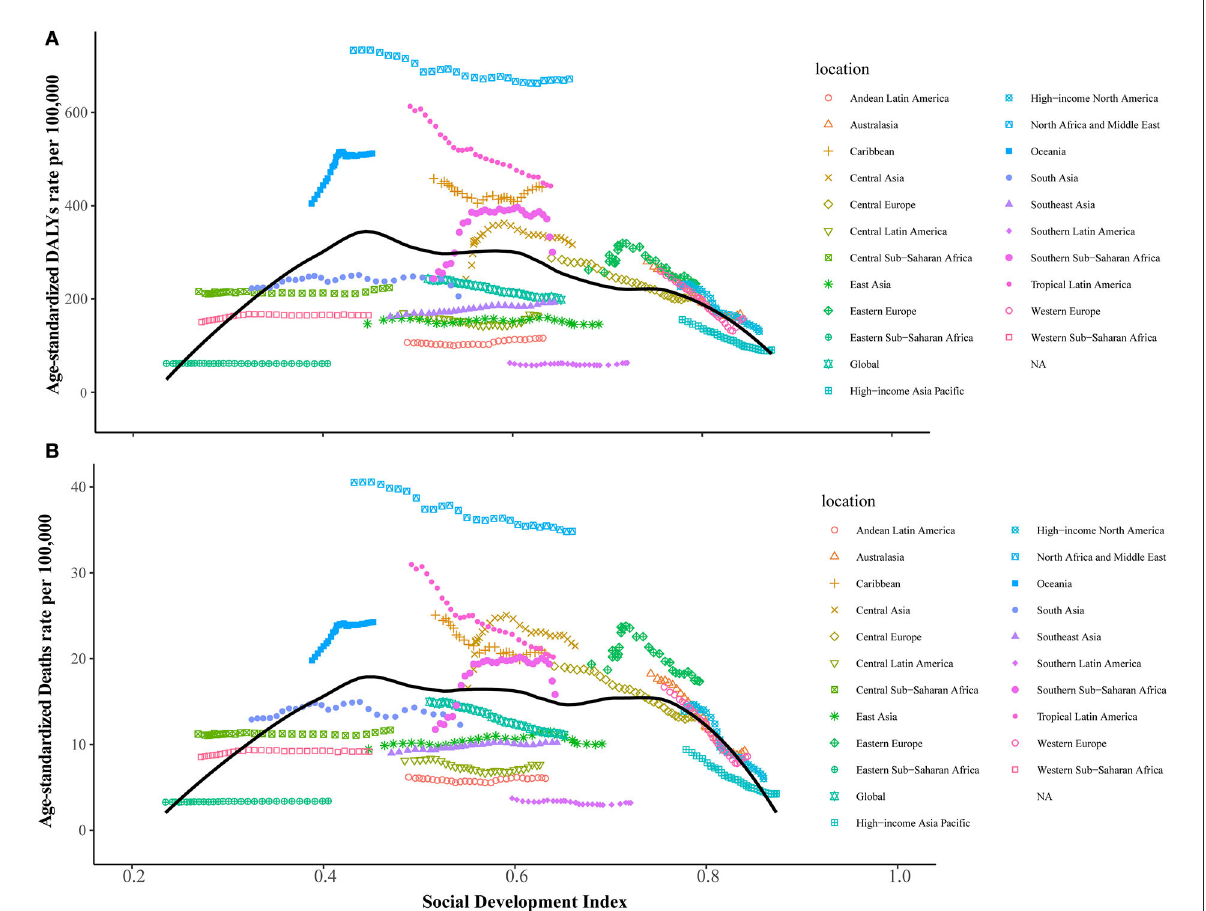
FIGURE4 Relationships between the age-standardized DALYs and death rates of disease attributable to low physical activity and SDI level across 21 GBD regions. (A) Age-standardized DALYs. (B) Age-standardized death